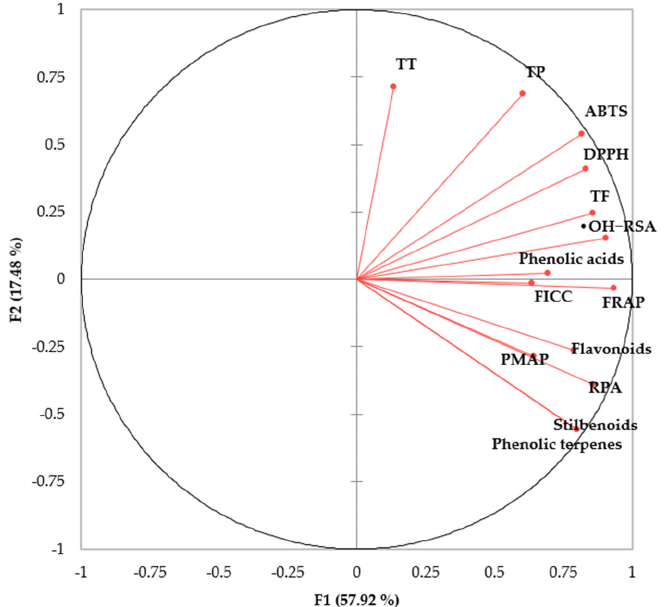
Figure 3. Principal component analysis (PCA) of the polyphenolic contents (TP, TF, TT, phenolic acids and flavonoids) and their antioxidant capacities (DPPH, ABTS, FRAP, RPA, •OH − RSA, PMAP and FICC) of 10 selected herbs.